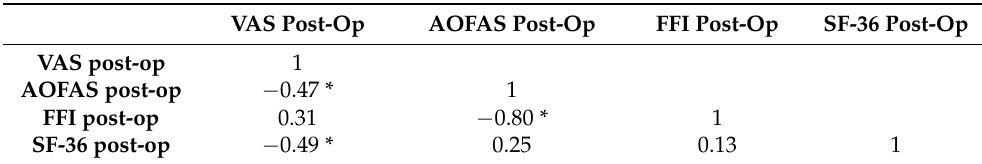
Table 3. A matrix of the Spearman correlation coefficient (rho) between VAS, AOFAS, FFI, and SF-36 post-op. VAS Post-Op AOFAS Post-Op FFI Post-Op SF-36 Post-Op VAS post-op 1 AOFAS post-op − 0.47 * 1 FFI post-op 0.31 − 0.80 * 1 SF-36 post-op − 0.49 * 0.25 0.13